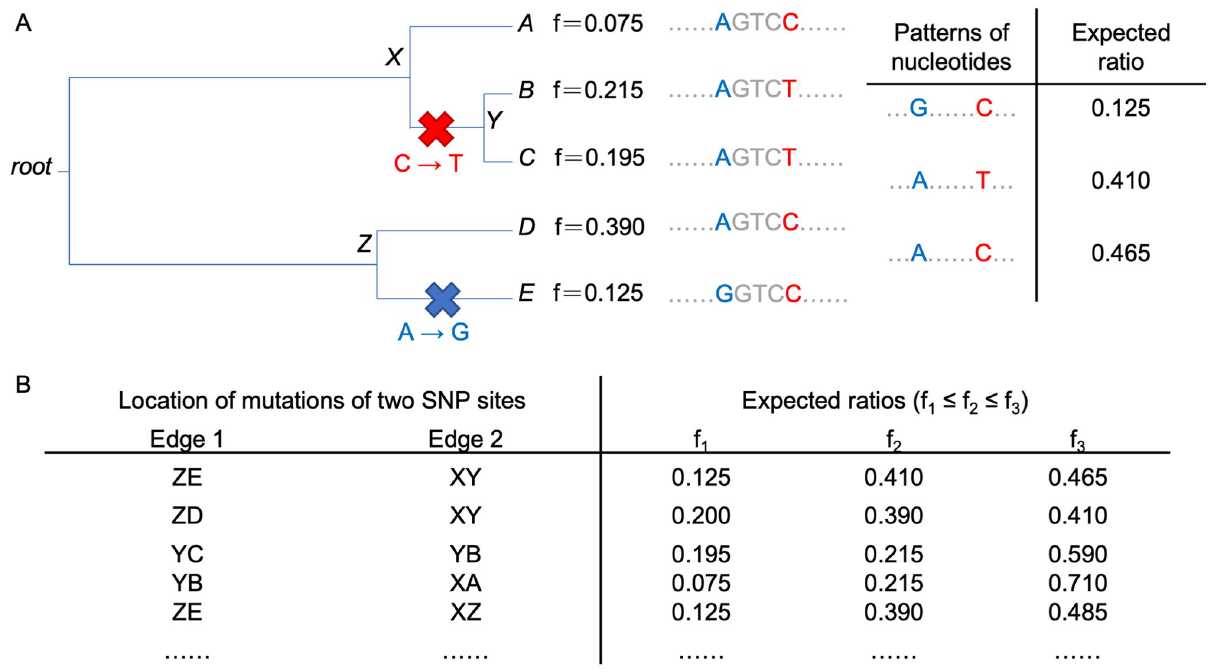
Fig 2. Consideration of connections between two SNP sites. (A) Under the infinite site model, by allowing one mutation along the tree for every SNP site, two SNP sites may make three different patterns of nucleotides . (B) Different locations of the mutations on the tree can result in different set of expected